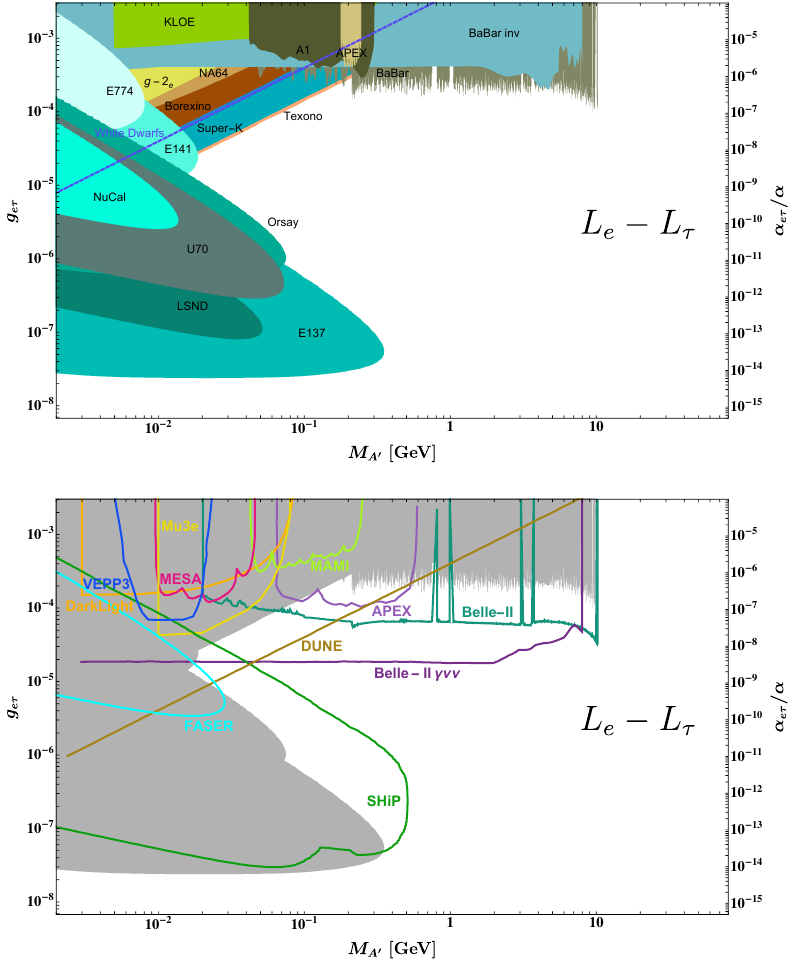
Figure 15 . Constraints from current (upper panel) and future (lower panel) experiments on a U(1) L gauge boson with gauge coupling g e e (cid:0) L (cid:28) cooling and BBN are not shown (see sections 3.6 and